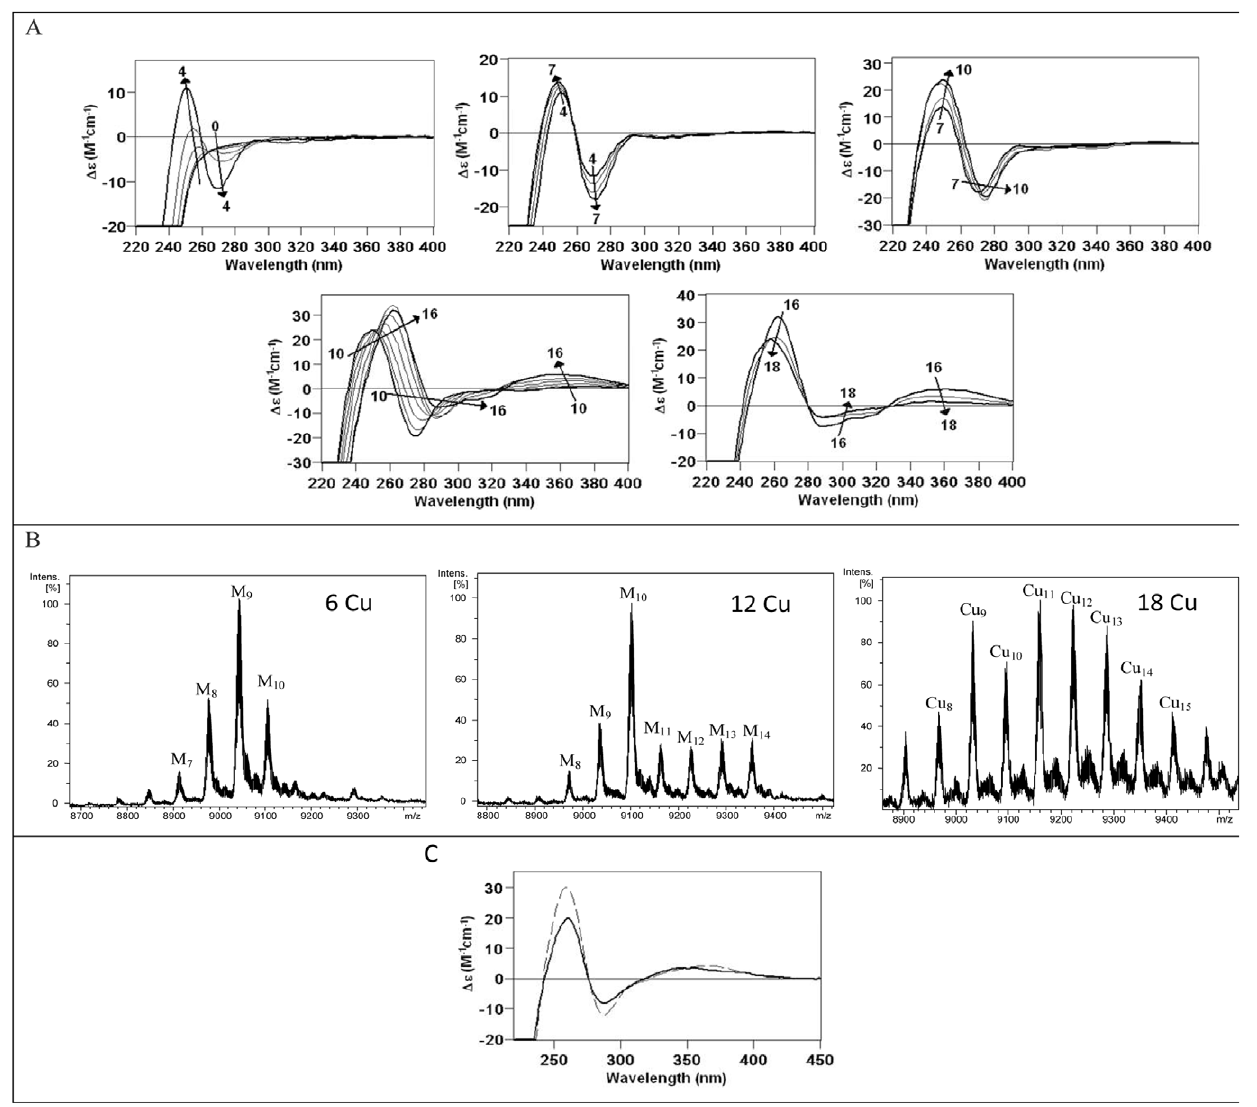
Figure 10. The invitro Cu(I) binding abilities of BfMT peptides shows the preference of BfMT1 vs . BfMT2 to coordinate this metal ion. (A) CD corresponding to the titration of a 10 m M solution of Zn-BfMT1 with Cu(I) at pH 7.0 until 18 Cu(I) eq added. The arrows show the number of Cu(I) eq added at each stage of the titration. (B) Deconvoluted ESI-MS spectrum of several aliquots extracted from the solution at 6, 12, and 18 Cu(I) eq added to Zn-BfMT1. (C) Comparison of the CD spectra of the recombinant Cu-BfMT2 preparation (solid line), and that of the Zn-BfMT1 sample after the addition of 12 Cu(I) eq (dashed line).